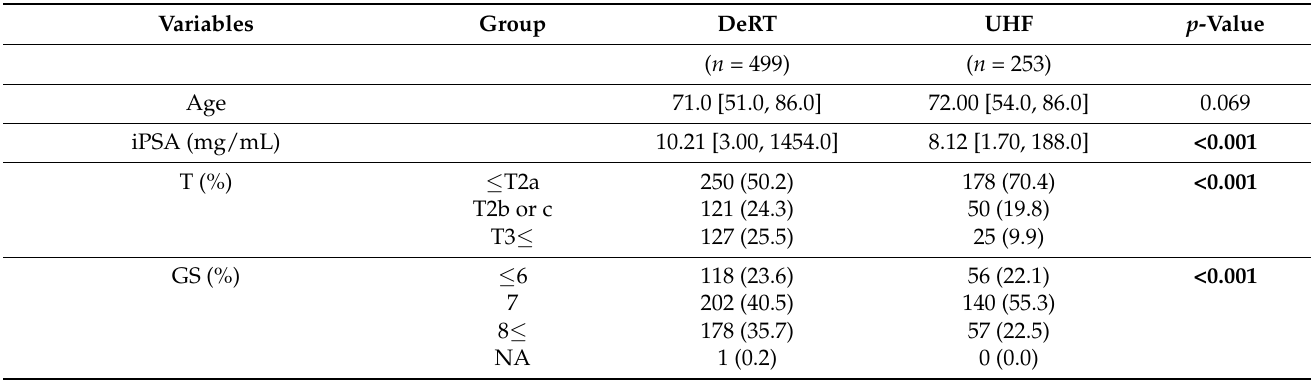
Table 1. Patients’ characteristics between ultrahypofrationated and conventional to medium hy- pofractionated